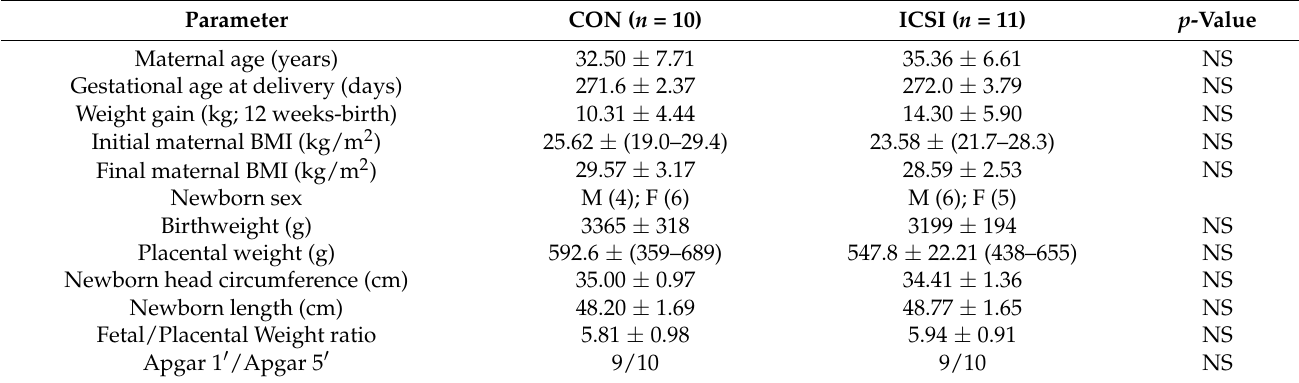
Table 2. Clinical and biometric profile of the pregnancies enrolled in the